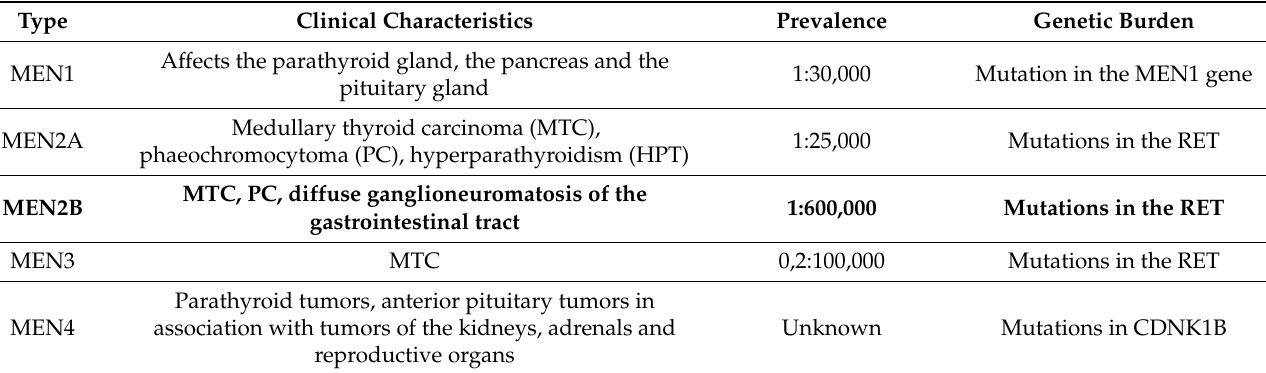
Table 1. Clinical characteristics and epidemiology of MEN